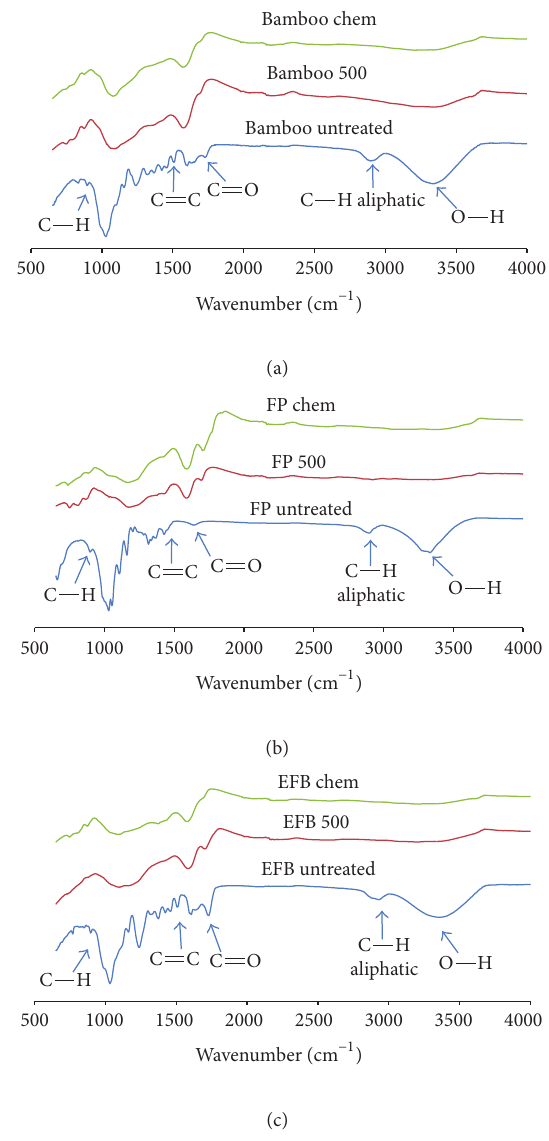
F 5: FT-IR spectrums of (a) bamboo, (b) FP, and (c) EFB C, and chemical dehydration). samples (untreated, heated at 500 ∘